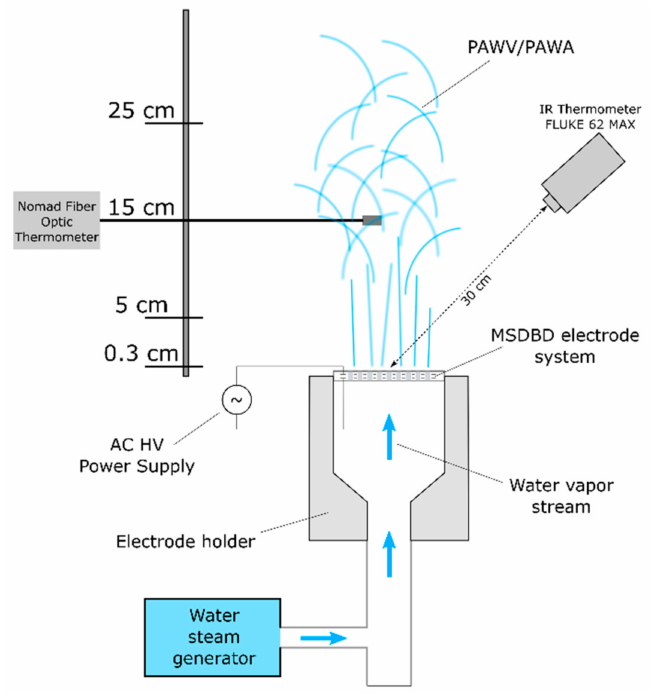
Figure 7. The schematics of the device for PAWV/PAWA generation and temperature